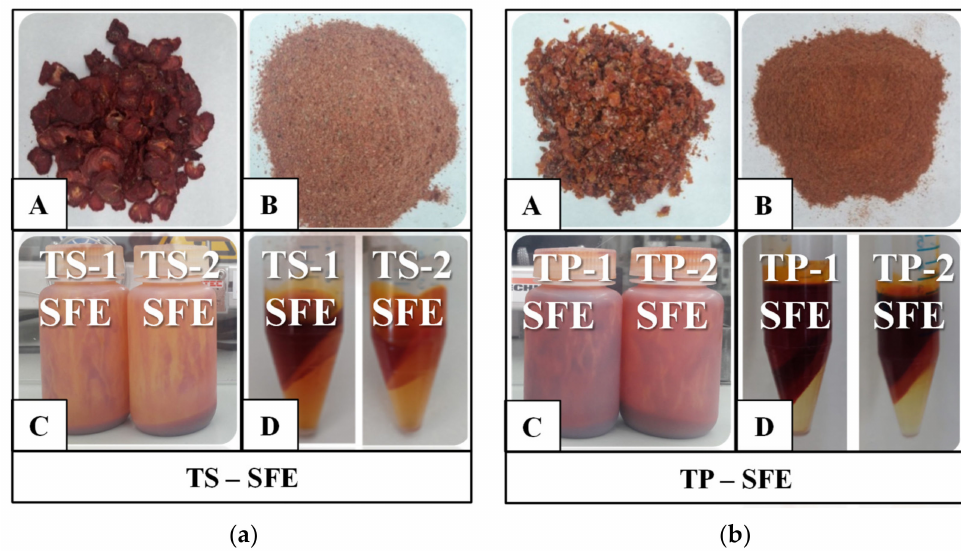
Figure 3. Tomato samples, raw extracts and centrifuged fractions obtained with supercritical CO 2 extraction (SFE) using operating parameter set (1) at 400 bar, 70 ◦ C, 9 kg/h and set (2) at 450 bar, 70 ◦ C, 11 kg/h. A—before grinding, B—after grinding, C—operating parameter sets raw extracts (1,2), D—operating parameter sets centrifuged extracts (1,2): ( a ) tomato slices (TS); ( b ) tomato pomace